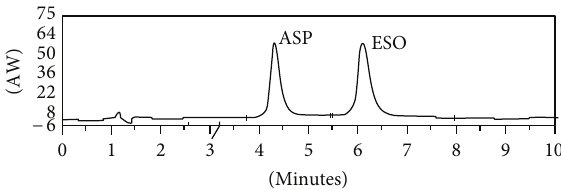
F 1: Structure of aspirin.